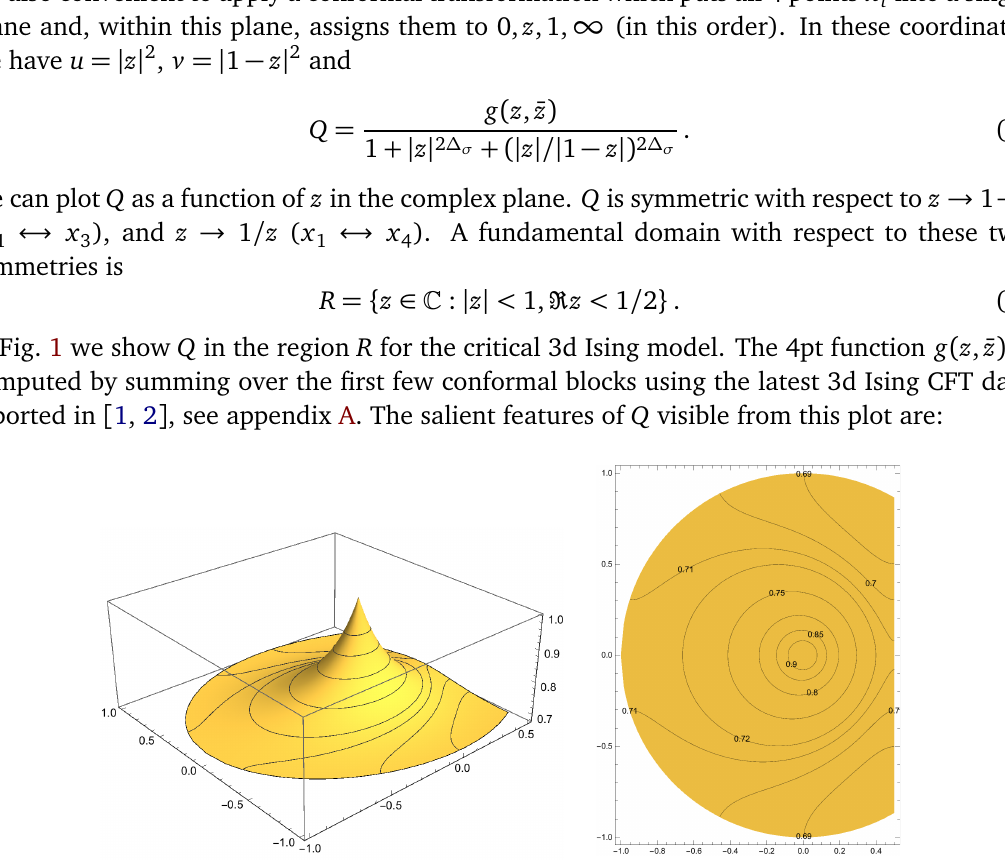
Figure 1: Q in critical 3d Ising, plotted in region R